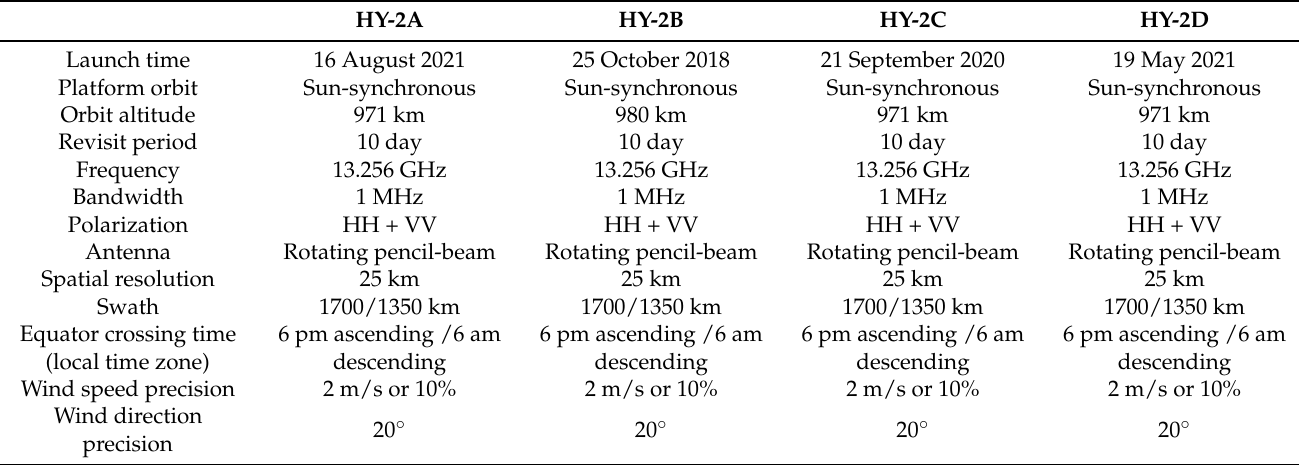
Table 1. Basic information of the Haiyang-2 satellite